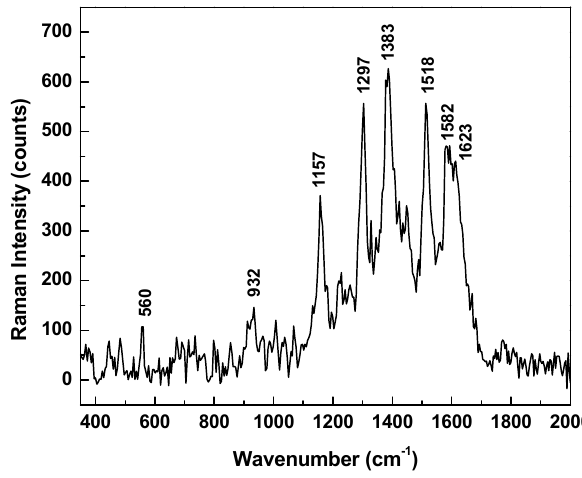
Figure 7. Overall average of 400 SERS spectra recorded in different spots on the sample (eight different time series acquisitions of 50 SERS spectra each, at 200 milliseconds per spectrum).